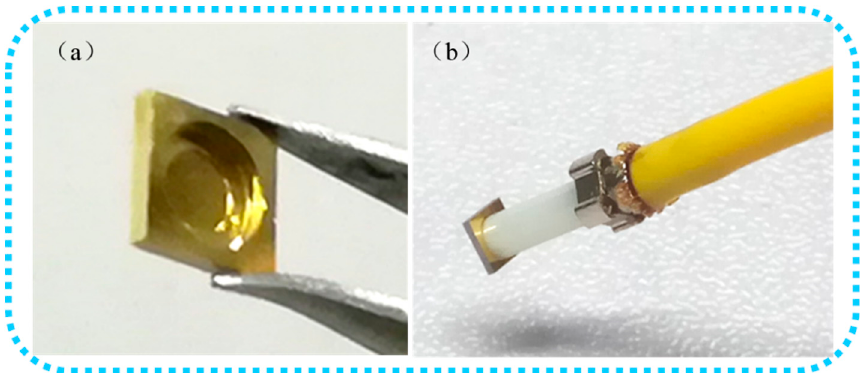
Figure 5. ( a ): Final processed diaphragm, ( b ): Final probe (removed from the protection structure).